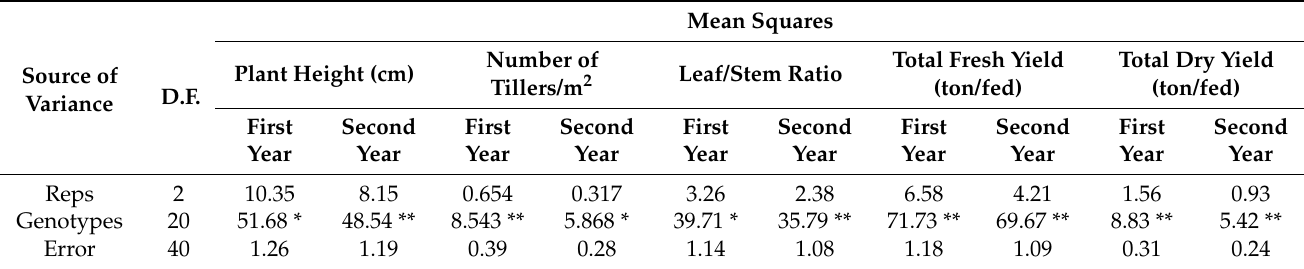
Table 3. Mean squares of yield components and forage yield of twenty-one alfalfa genotypes in two years.